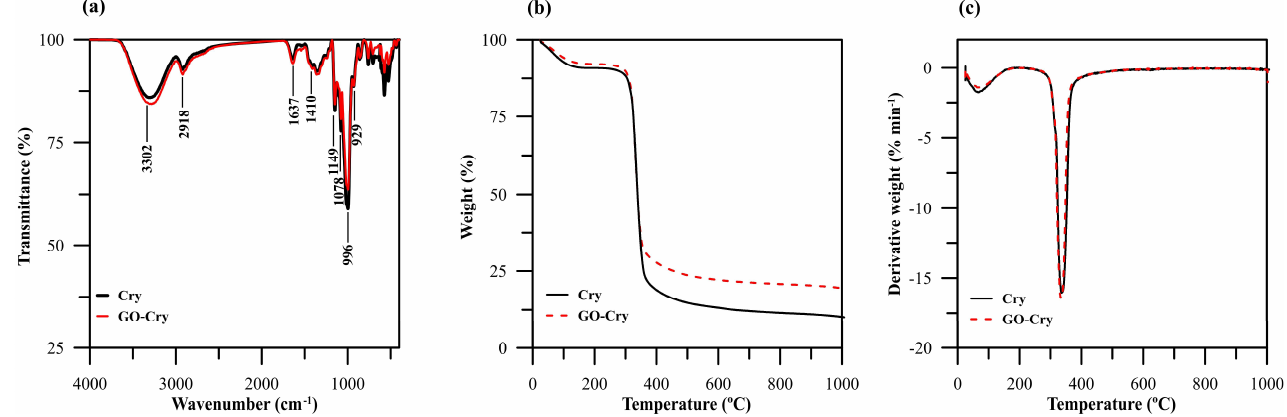
Figure 4. ( a ) FTIR spectra ( b ) TGA ( c ) DTG of Cry and GO-Cry. The XRD patterns of the GO-Cry (Figure 3d) displayed a strong peak at 2 θ ~26.4 ◦